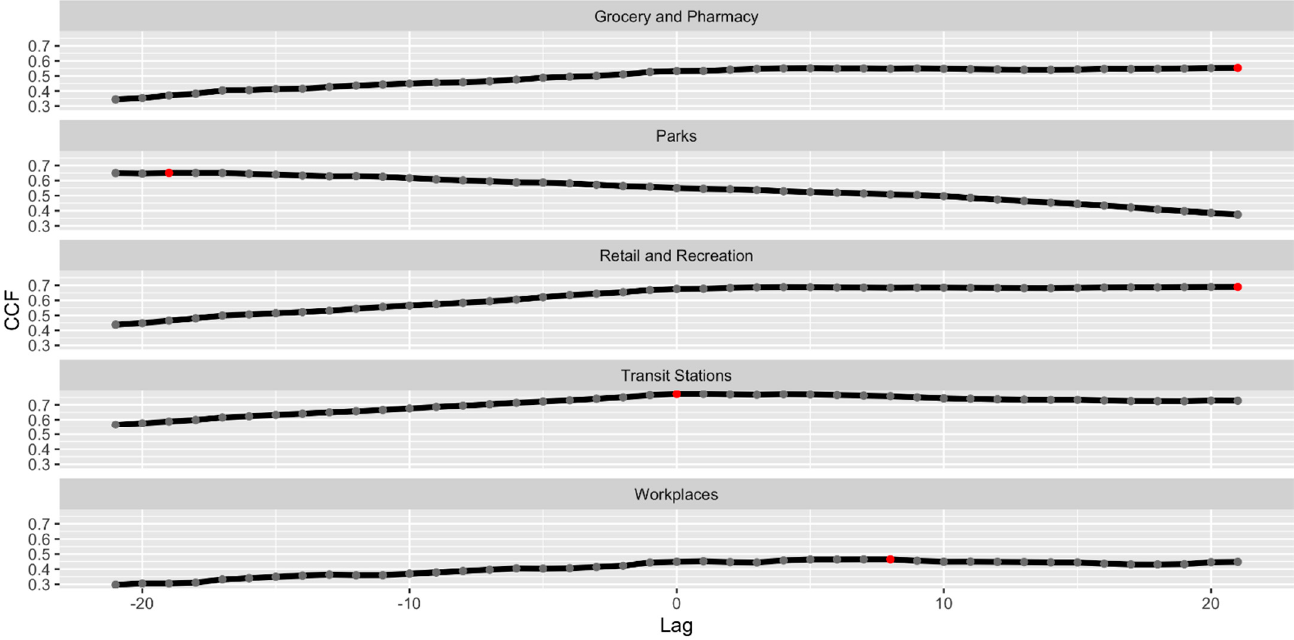
Figure 1. Correlation plot between independent variables and daily confirmed case variables at a different time lag.